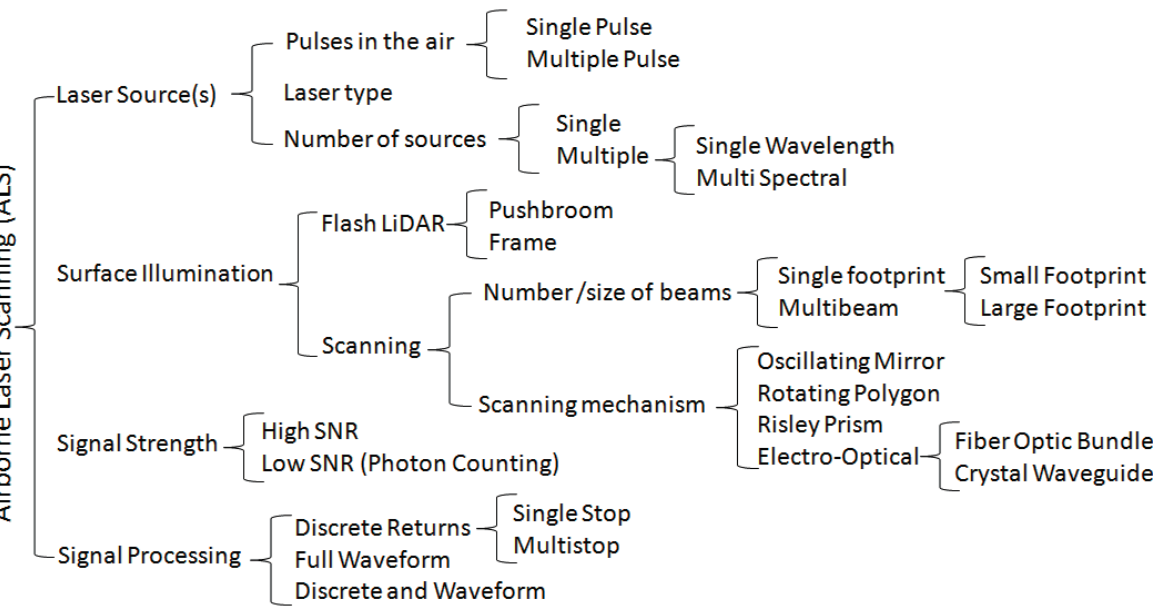
Figure 1. Technical classification of Airborne Laser Scanning